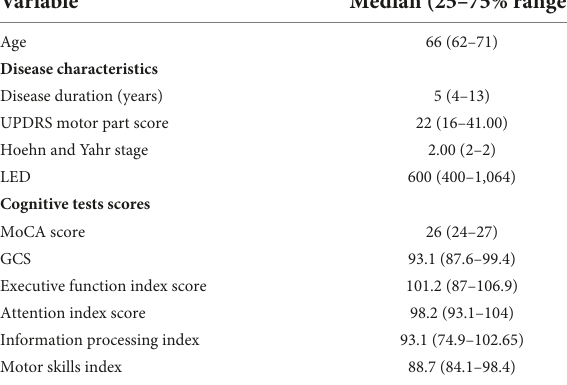
TABLE 1 Demographics, disease, and cognitive characteristics of the